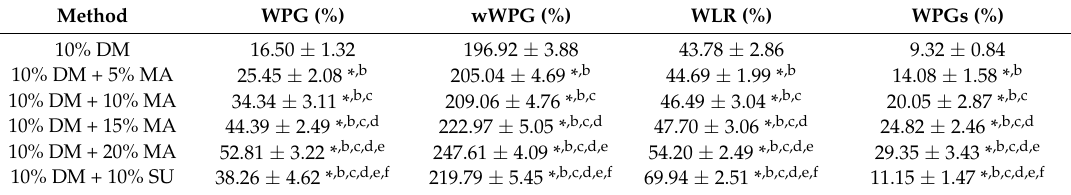
Figure 3. WPG and wWPG of the wood treated with 10% DM and chemicals at different concentrations ( a , c ); WLR and WPGs after leaching of wood treated with 10% DM and chemicals at different concentrations ( b , d ). Table 1. Changes in the WPG, wWPG, WLR and WPGs of wood treated with different